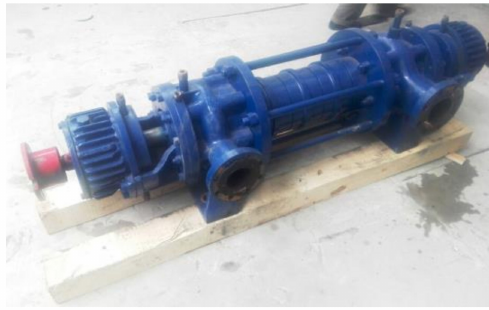
Figure 1. The six-stage multiphase pump.